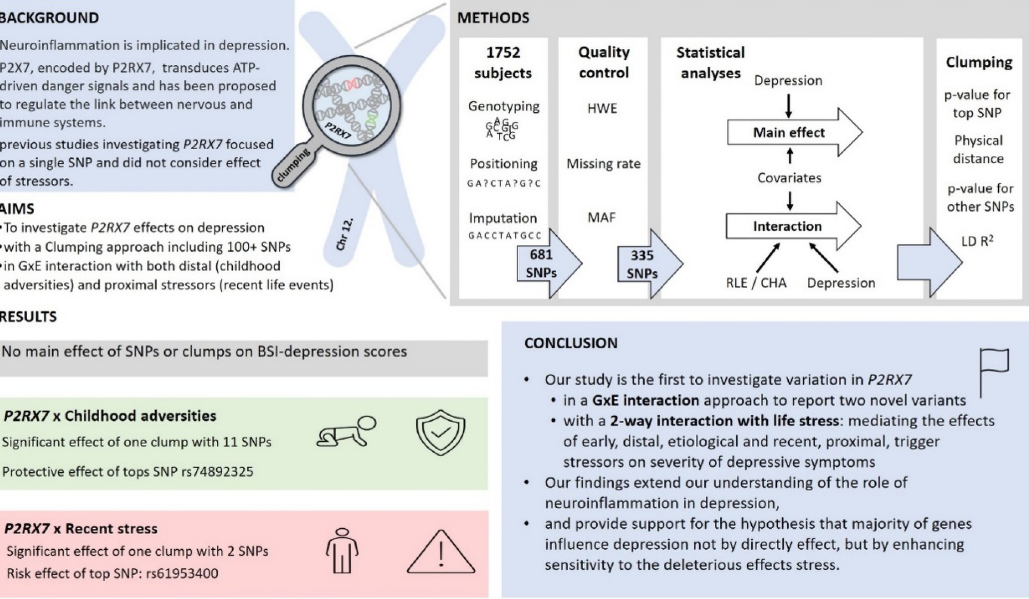
Fig 5. A summary of the study on the effect of P2RX7 variation in interaction with childhood adversity and recent stress on the severity of depressive symptoms.